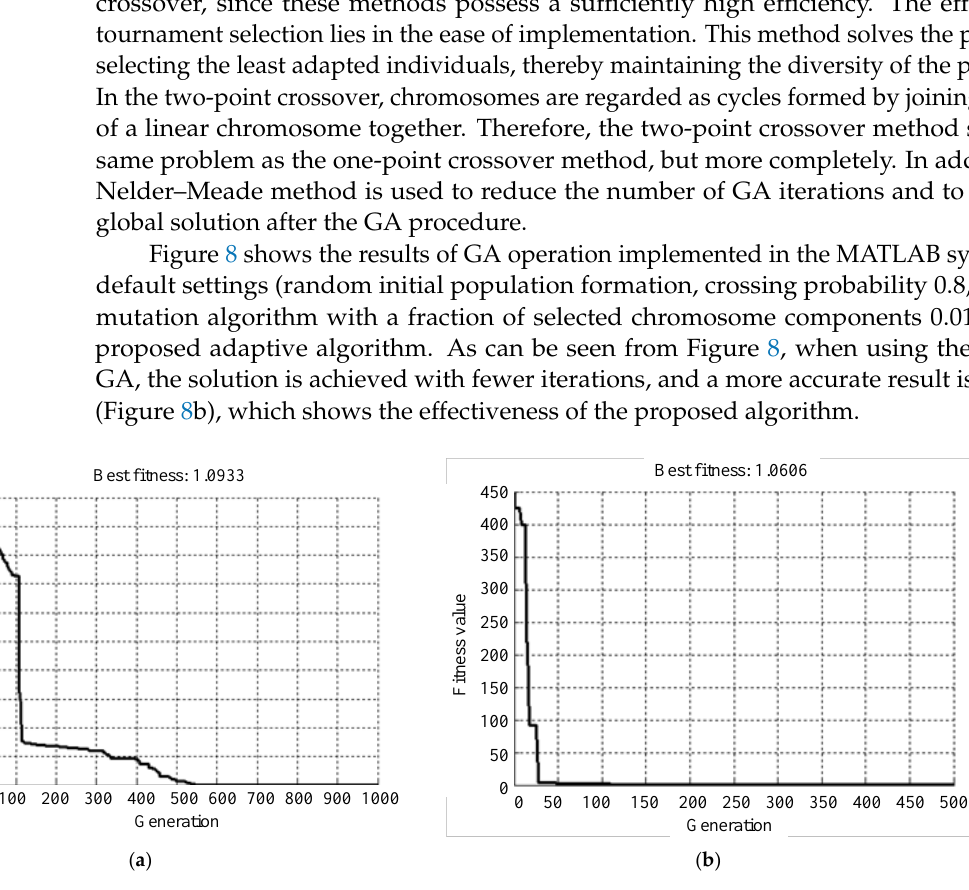
Figure 8. Dependences of the best value of the fitness function of individuals on the generation with default GA settings ( a ) and optimal settings ( b ).